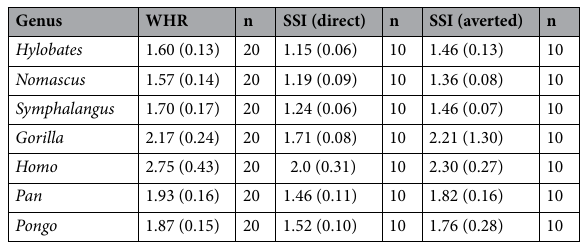
Table 2. Median values (± SD) of width-height ratio (WHR) and scleral size index (SSI) during direct and averted gaze in seven hominoid